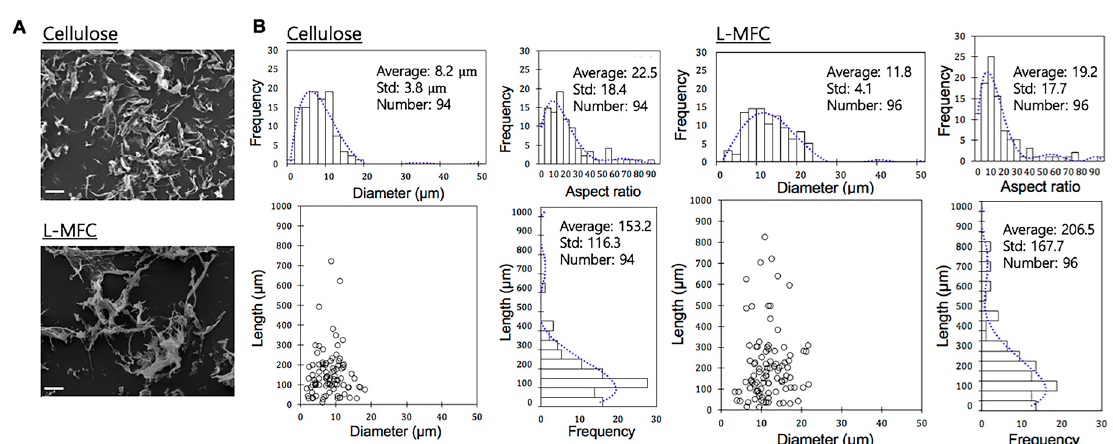
Figure 1. Chemical compositions and morphological characterization of cellulose, L-MFC, and lignin used in this study. ( A ) The scanning electron microscopy (SEM) images of cellulose (left) and L-MCF (right). A scale bar, 20 µm. ( B ) Optical image analyses of cellulose and L-MFC.